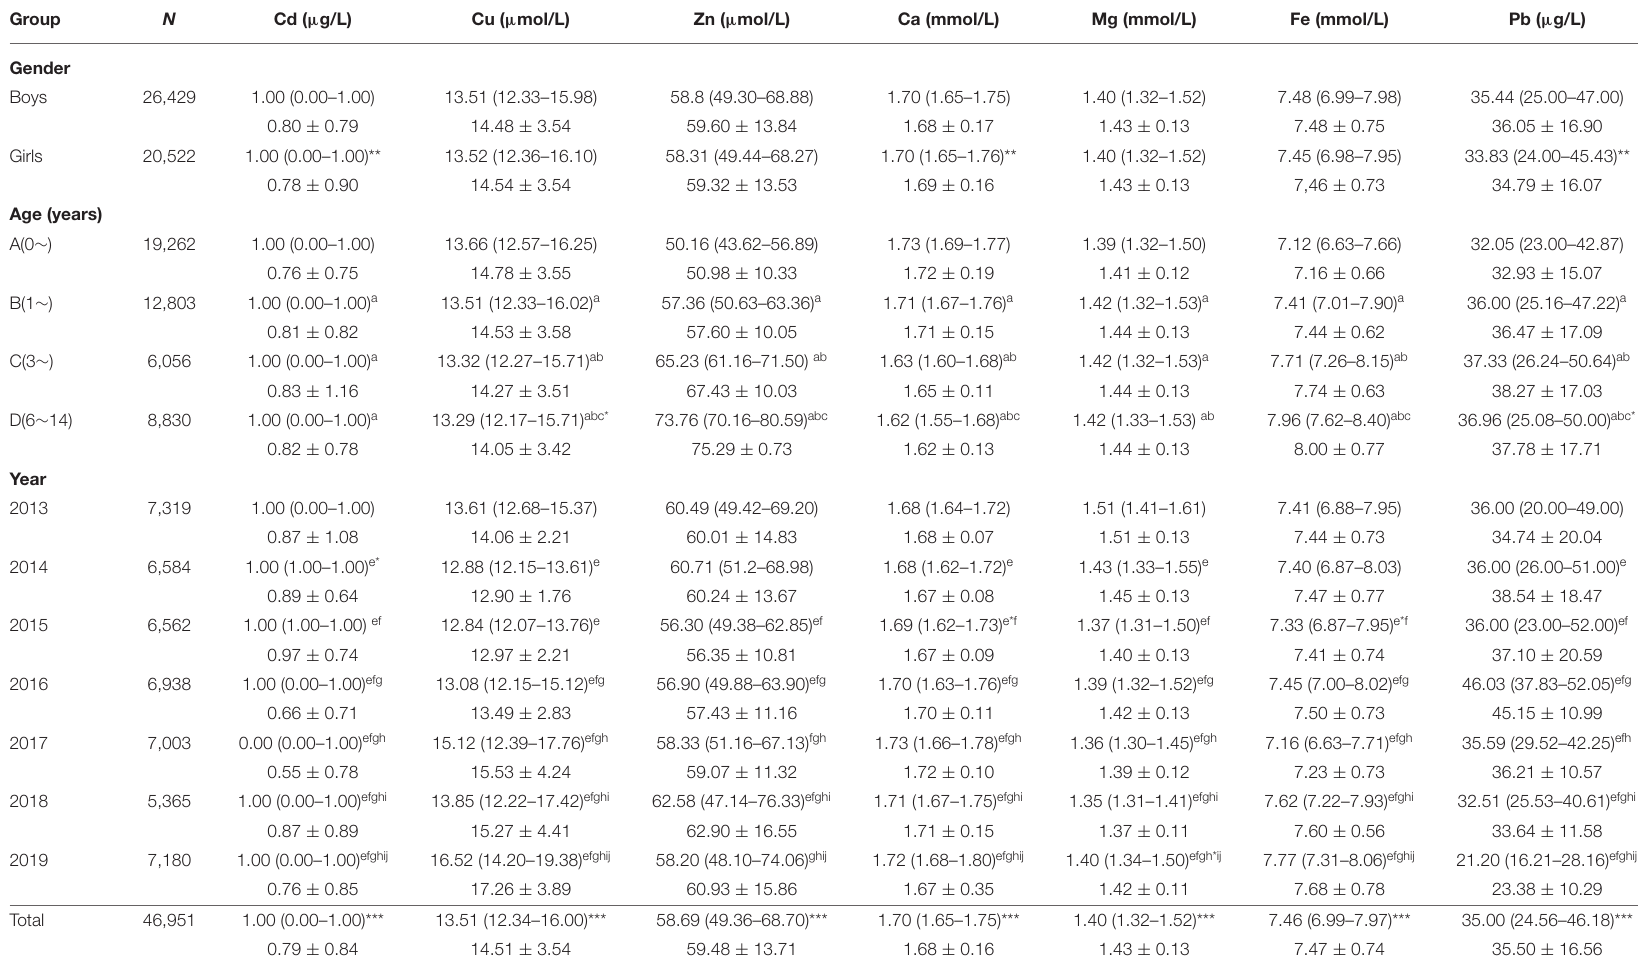
TABLE 1 | Comparison of toxic and essential element levels in the blood of children age from 0 to 14 in Hunan, China, based on gender, age, and year.